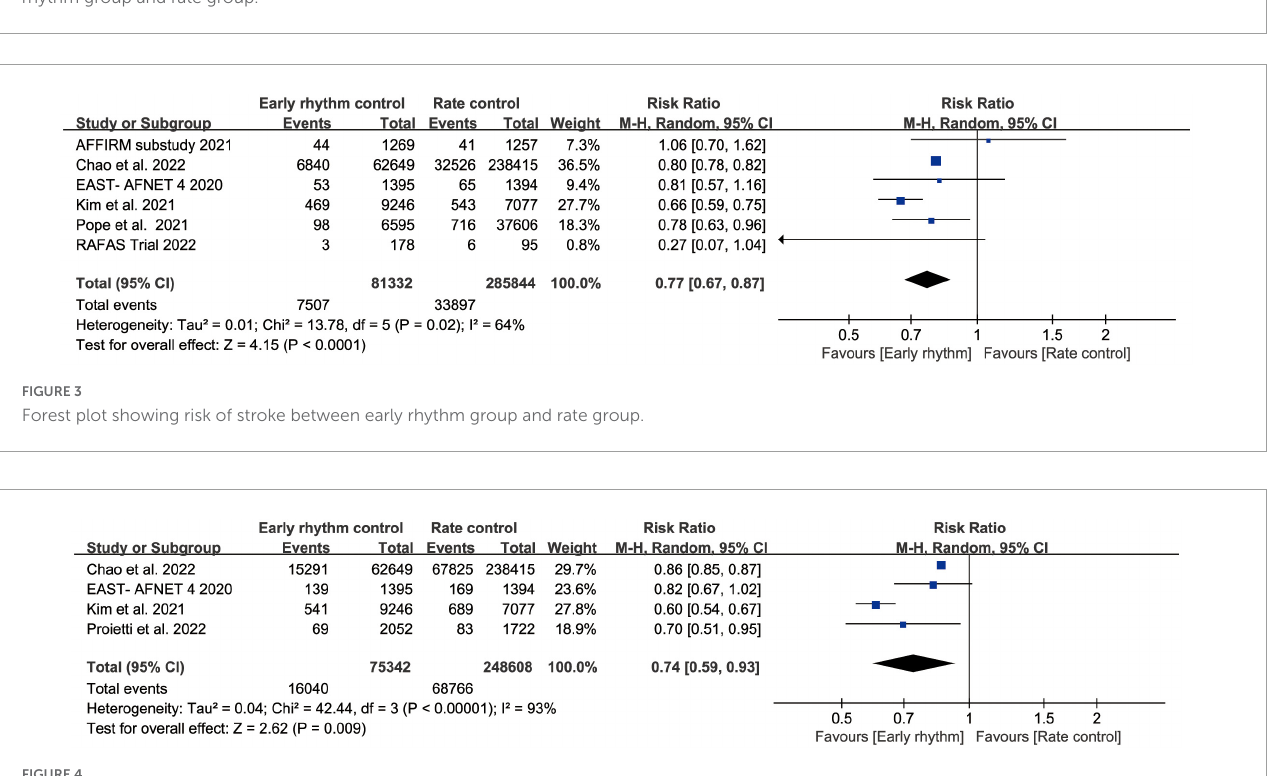
the two groups for acute coronary syndrome, major bleeding, nights spent in the hospital per year, and cardiac arrest/ventricular arrhythmia. To the best of our knowledge, our systematic